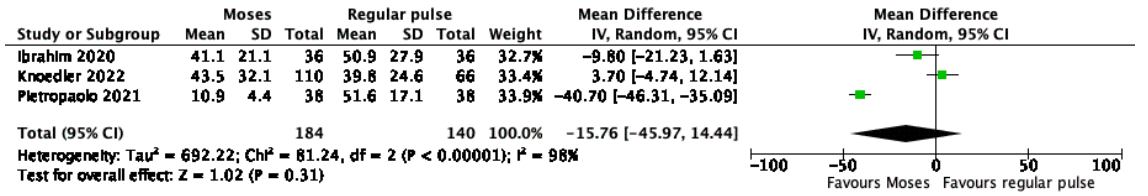
Figure 4. Forest plot of the meta-analysis comparing fragmentation time between Moses versus regular pulse modulation [18,35]. Figure 5. Forest plot of the meta-analysis comparing post-operative complications between Moses versus regular pulse modulation [18,35,37,38]. 5. Discussion In 2017, Lumenis Moses Technology inaugurated the new pulse modulation era, followed by the other pulse modes developed by Quanta System, Dornier MedTech, and Olympus. As our systematic review shows, most of the studies, both in-vitro and in-vivo, have analyzed Moses PM. This is explained by the fact that it was the first new-generation PM, and many authors wanted to test how this possible game-changing tool could and should be applied. Surprisingly, no articles studying the Olympus’ Stabilization Mode were found to support the commercial claim that this PM produces a vapor tunnel bubble that clears a path through the water to reduce retropulsion [41]. Regarding Advance Mode (Dornier MedTech), only one in-vitro article was found [33]. Marketing material distributed by the company on the website claims that AM reduces stone movement during lithotripsy and patient treatment time [42]. However, Ho et al. [33] showed that Fragmentation Mode (with a total width at half of the maximum pulse duration of 75 μ s) generated larger craters than the Advance Mode (with a longer total width at half of the maximum pulse duration of 200 μ s). It seems that the only difference between these pulse settings is pulse length, and no information is available regarding their pulse shapes or associated retropulsion. As noted above, Lumenis Moses PM is the most represented in the reviewed studies, especially when comparing Moses to regular short and long pulses. Before Moses technology, studies had shown that regular short pulse length was more ablative than long pulse [43,44,45]. Despite this apparent lower efficiency, long pulse has shown to produce less fiber tip degradation and stone retropulsion in-vivo and in-vitro [46,47], as well as generation of smaller fragments [48], being a more suitable option for dusting